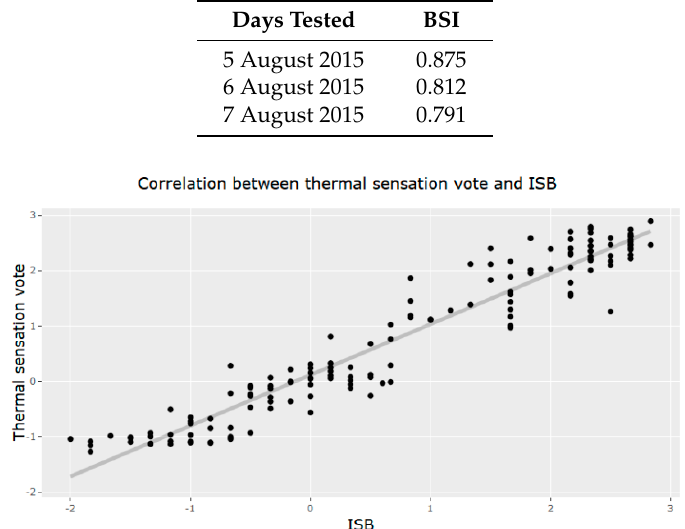
Table 8. Accuracy score by t -test ( p -value = 0.05).